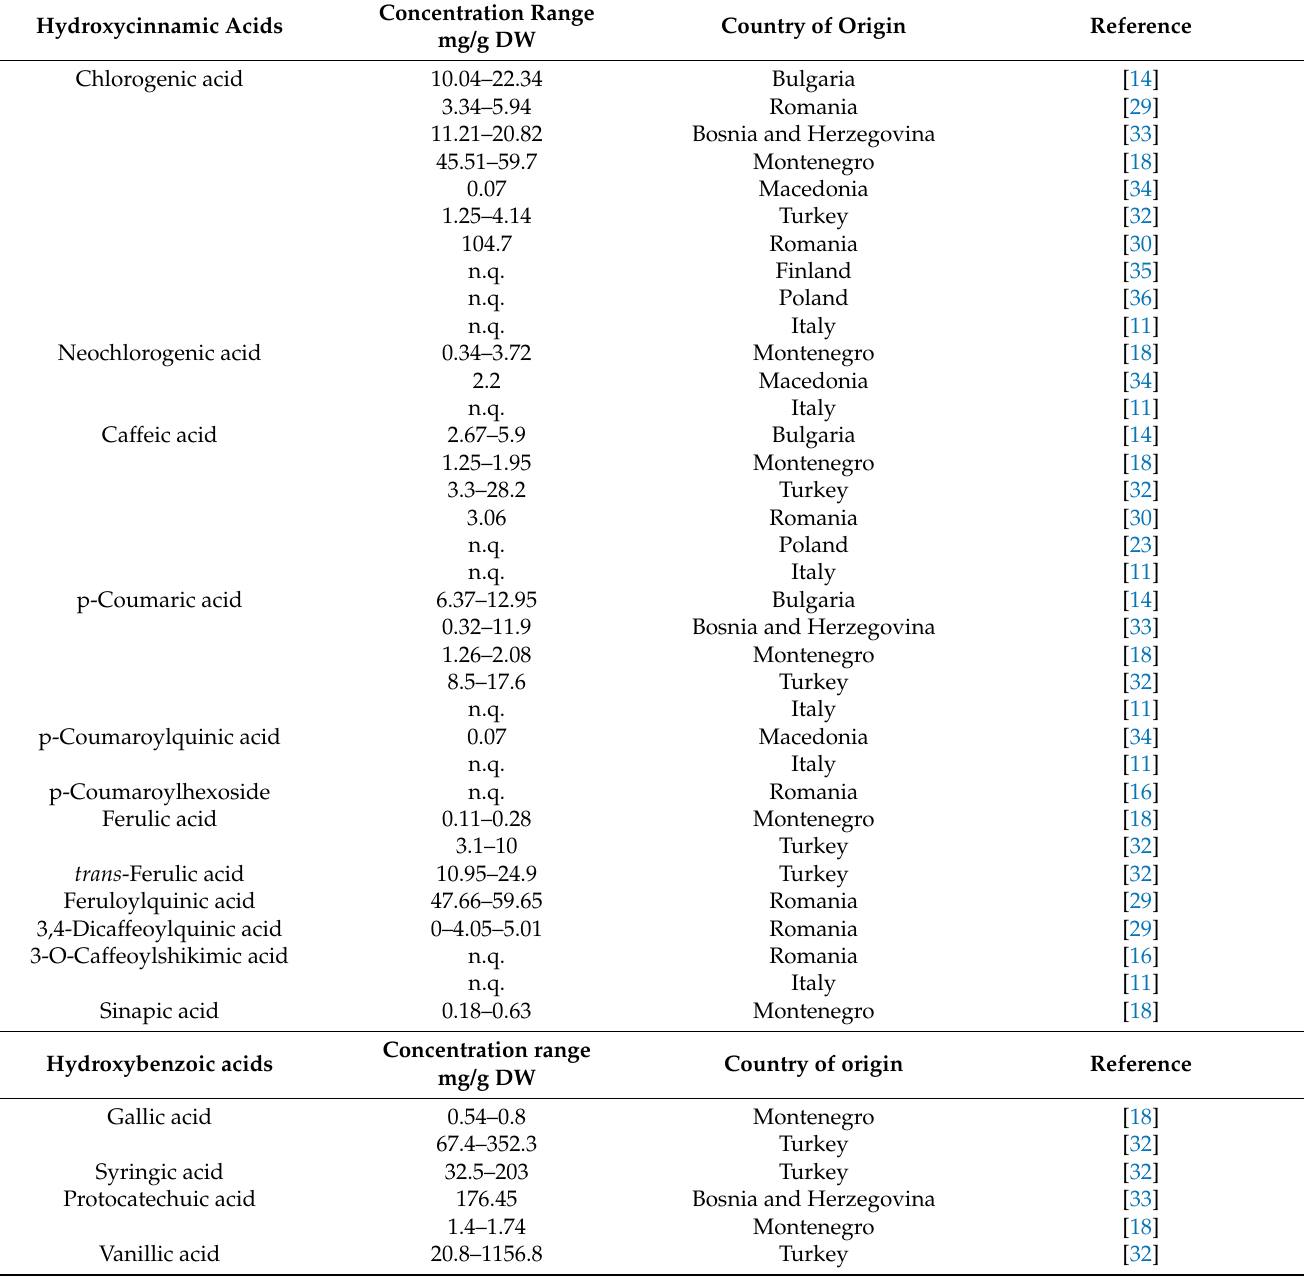
Table 5. Individual polyphenols identified in bilberry